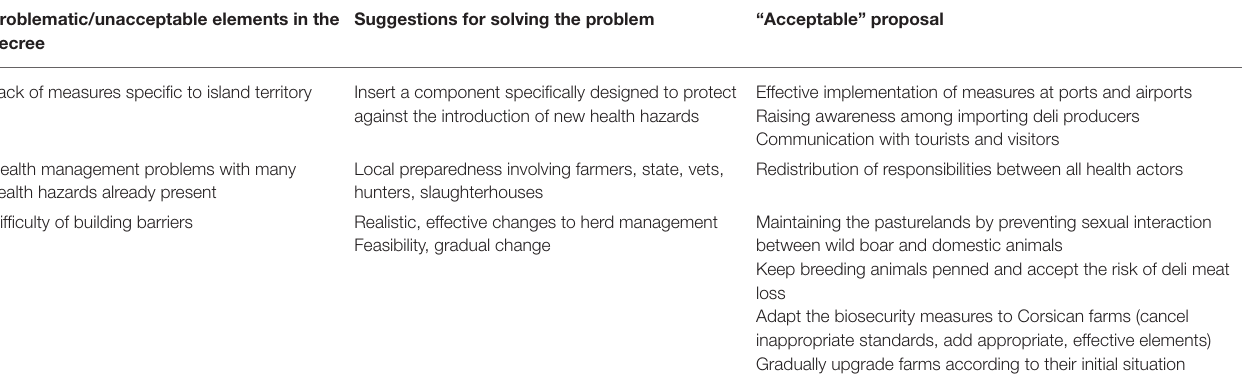
TABLE 3 | Proposals from the local technical committee on the unacceptable elements for Corsican pig farmers of the national biosecurity measures against African swine fever. Problematic/unacceptable elements in the